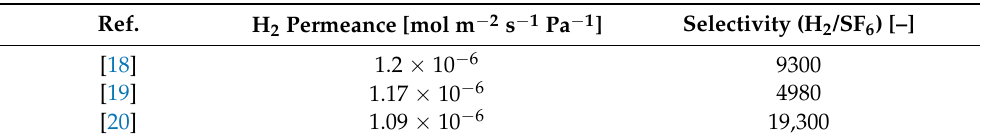
Figure 6. Structures of heat conductive fins to improve heat transfer from the heat medium to the catalyst layer.